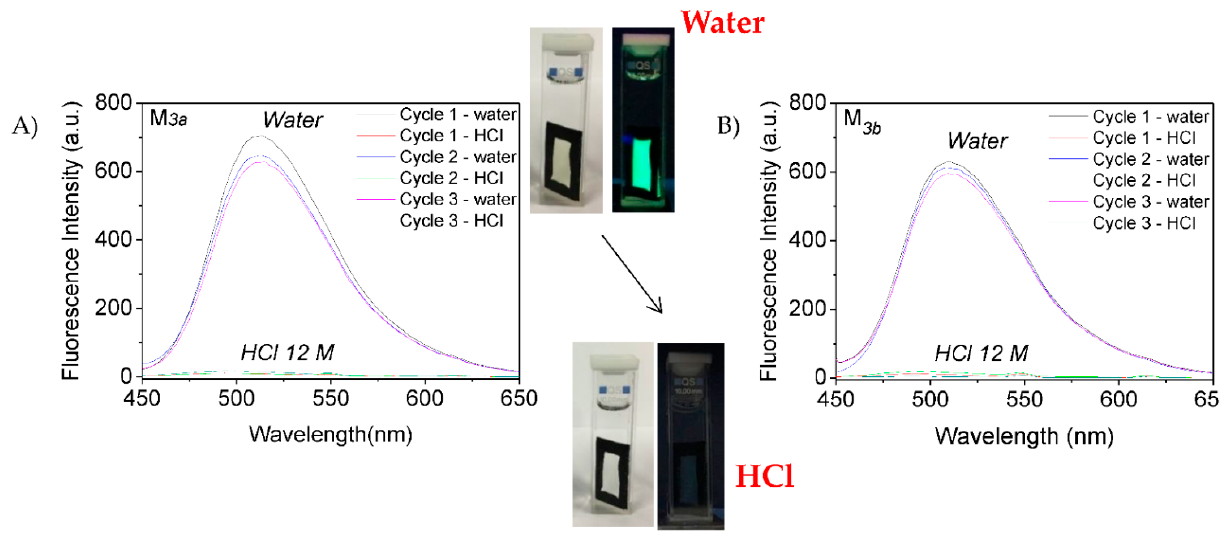
Figure 4. Reversibility of M 3a ( A ) and M 3b ( B ) by immersion in HCl (12M) followed by washing in pure water. Photographs showing the fluorescence change of films immersed in water or